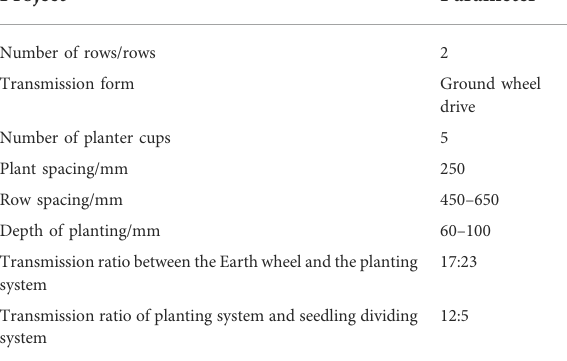
TABLE 1 Main design parameters of the transplanting mechanism.